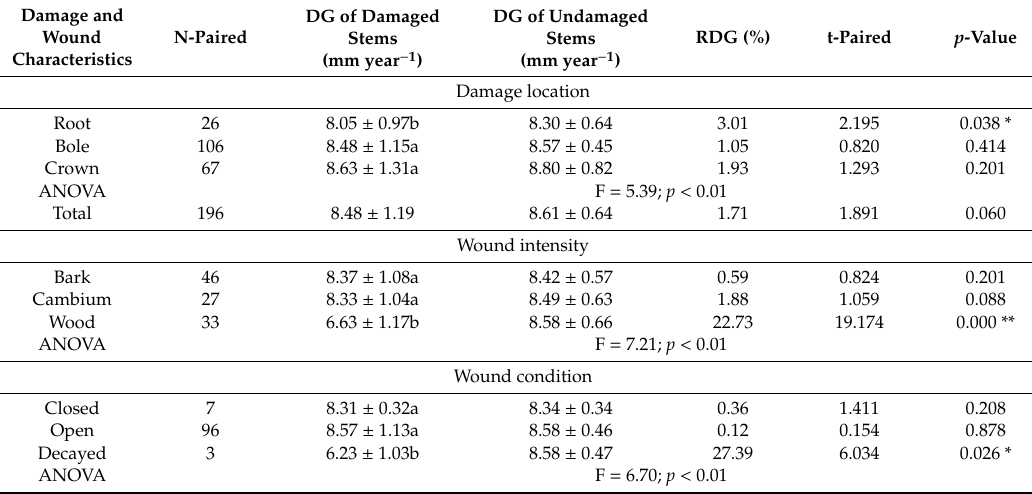
Table 5. Diameter growth (DG; mean ± SD) of damaged and undamaged loblolly pine trees, reduction of diameter growth (RDG), and results of ANOVA, t-paired, and Duncan tests for the analysis of the e ff ect of damage and wound characteristics (in 2016) on DG over a period of three years after thinning operations.